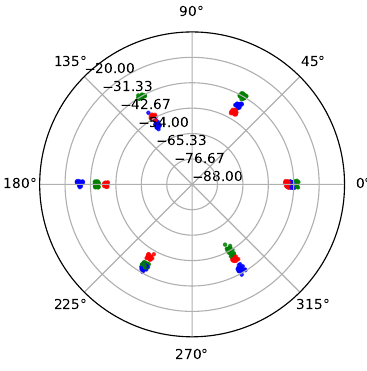
Figure 10. RSS measurements in dBm unit using one receiver antenna at the positions from P1 to P6 on the measurement platform. Transmitter and receiver devices are 4 m apart in distance and both devices use the external 6 dBi omnidirectional